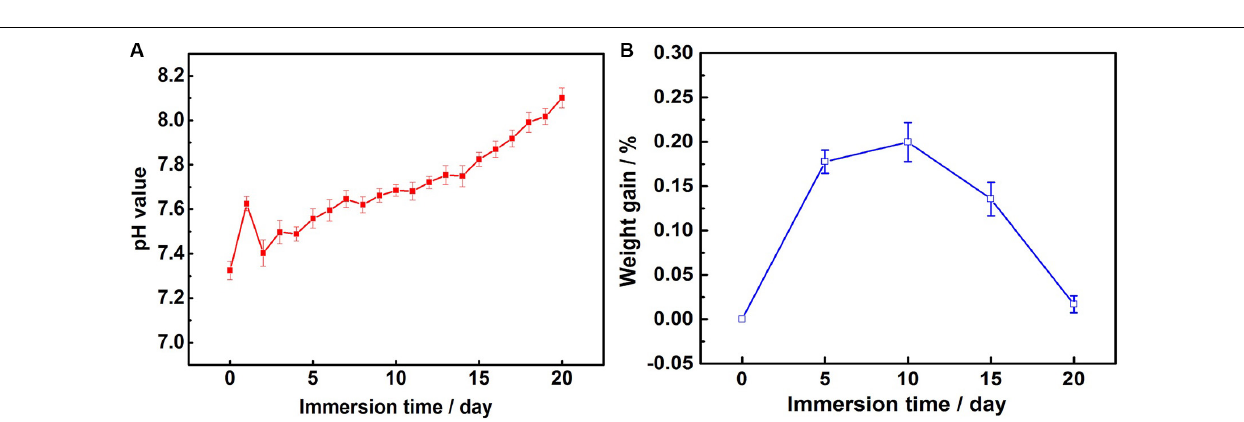
Frontiers in Materials |